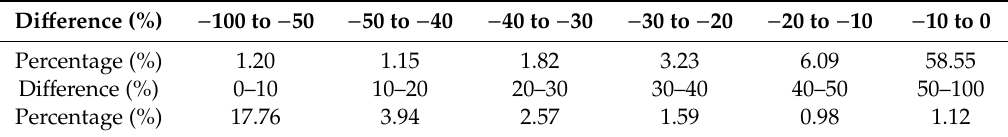
Table 3. Statistical classifications of the differences in grassland cover in 2000 between our reconstruction and CLUDs.